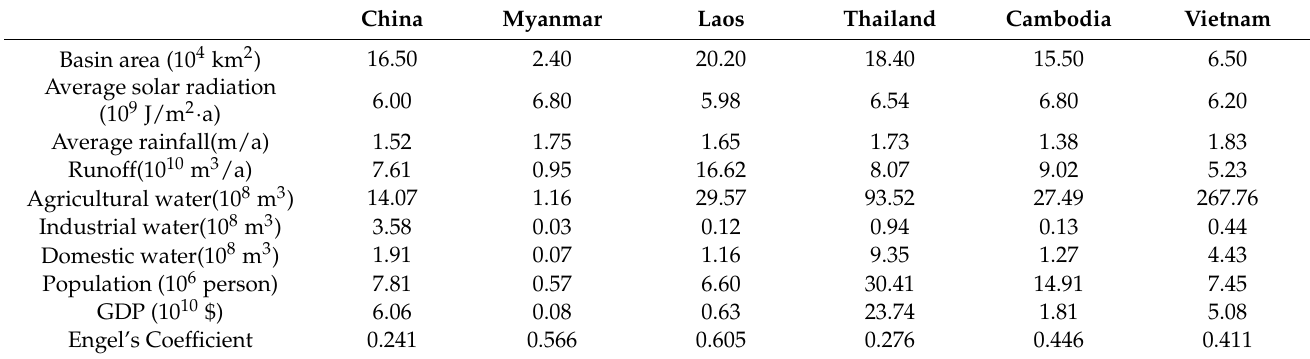
Table 1. Related indicators of